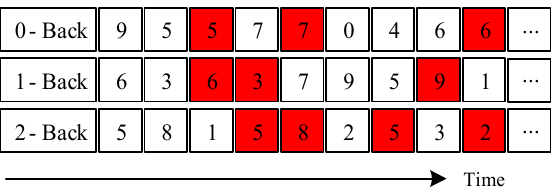
Figure 4. N–Back auditory feedback task diagram.